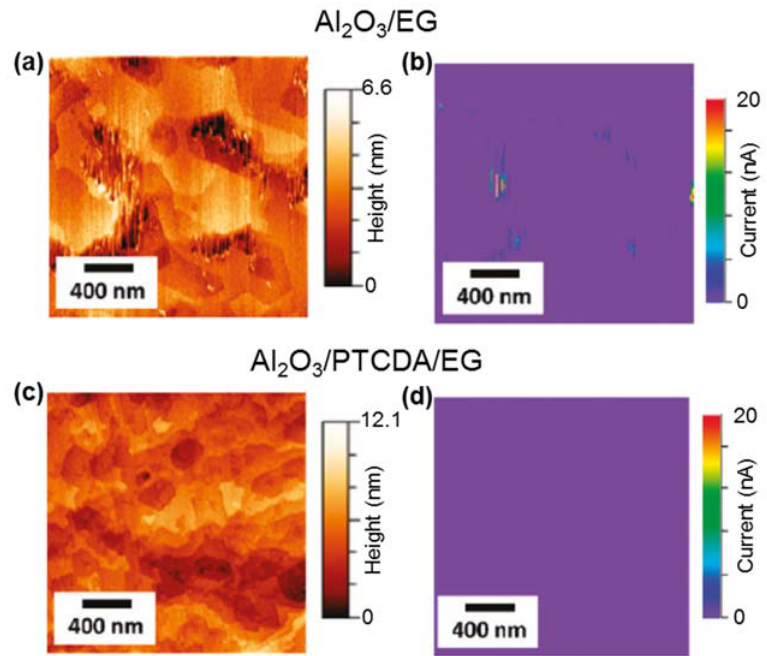
Figure 10. C-AFM morphology ( a ) and current map ( b ) of Al 2 O 3 deposited by 25 ALD cycles on the bare EG surface. Morphology ( c ) and current map ( d ) of Al 2 O 3 deposited with the same number of cycles on the PTCDA/EG surface. Images adapted with permission from Ref. [36], copyright American Chemical Society 2011.